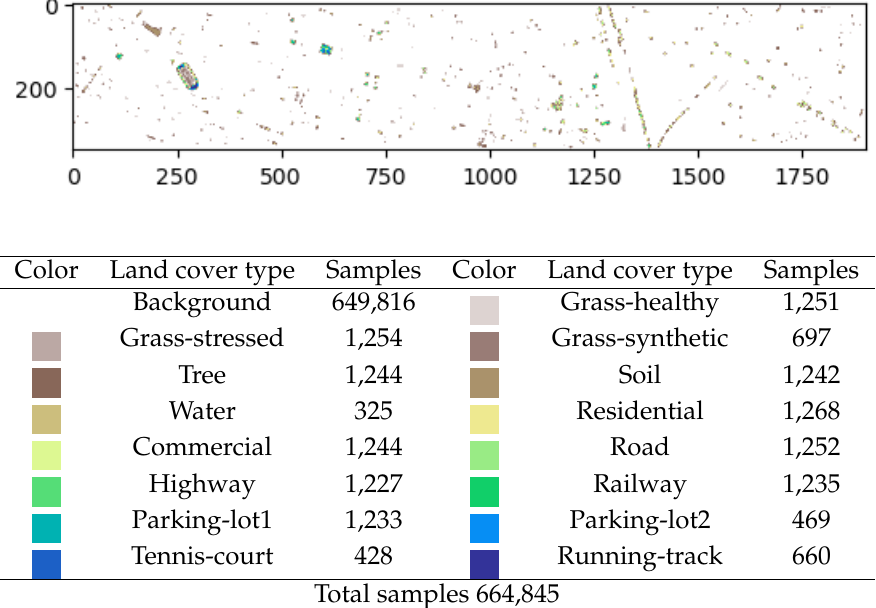
Figure 6. Ground truth of University of Houston